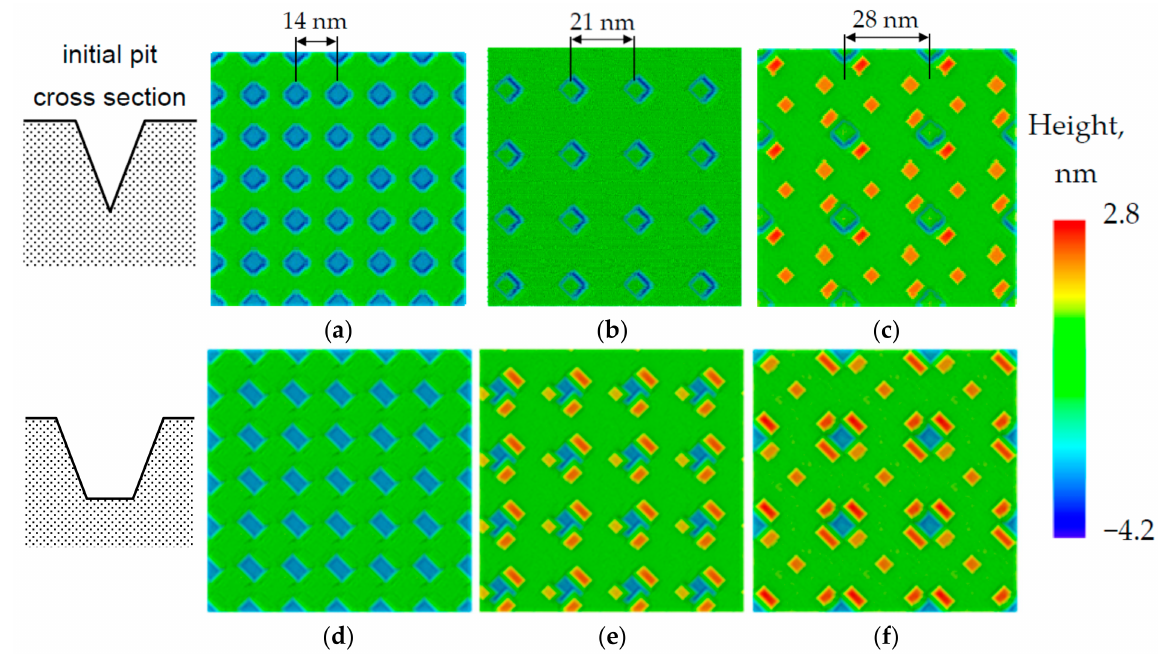
Figure 1. Calculated morphology of the pit-patterned Si(001) substrate with V-shaped ( a – c ) and U-shaped ( d – f ) pits after deposition of 5 ML of Ge. The initial cross-section for V- and U-shaped pits is presented to the left of corresponding calculated results. The growth temperature is 450 ◦ C. The rate of Ge deposition is 0.1 ML/s. The distance between the pits is 14 nm ( a , d ), 21 nm ( b , e ) and 28 nm ( c , f ). For all figures, the diameter of pits is 13.6 nm, their depth is 2.8 nm, and the pit sidewall inclination angle is 45 ◦ . All sizes are scaled down by the factor of 35 with respect to the experimental data. The zero height level in the color legend corresponds to the flat surface level between the